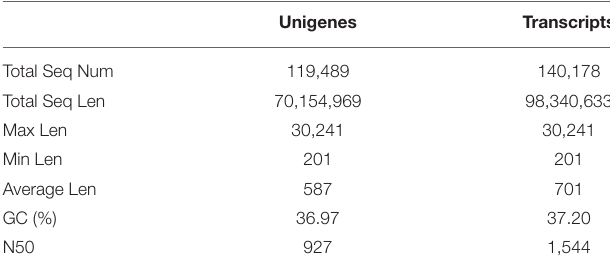
TABLE 1 | An overview of the transcriptome sequencing and assembly of Eucryptorrhynchus brandti at different developmental